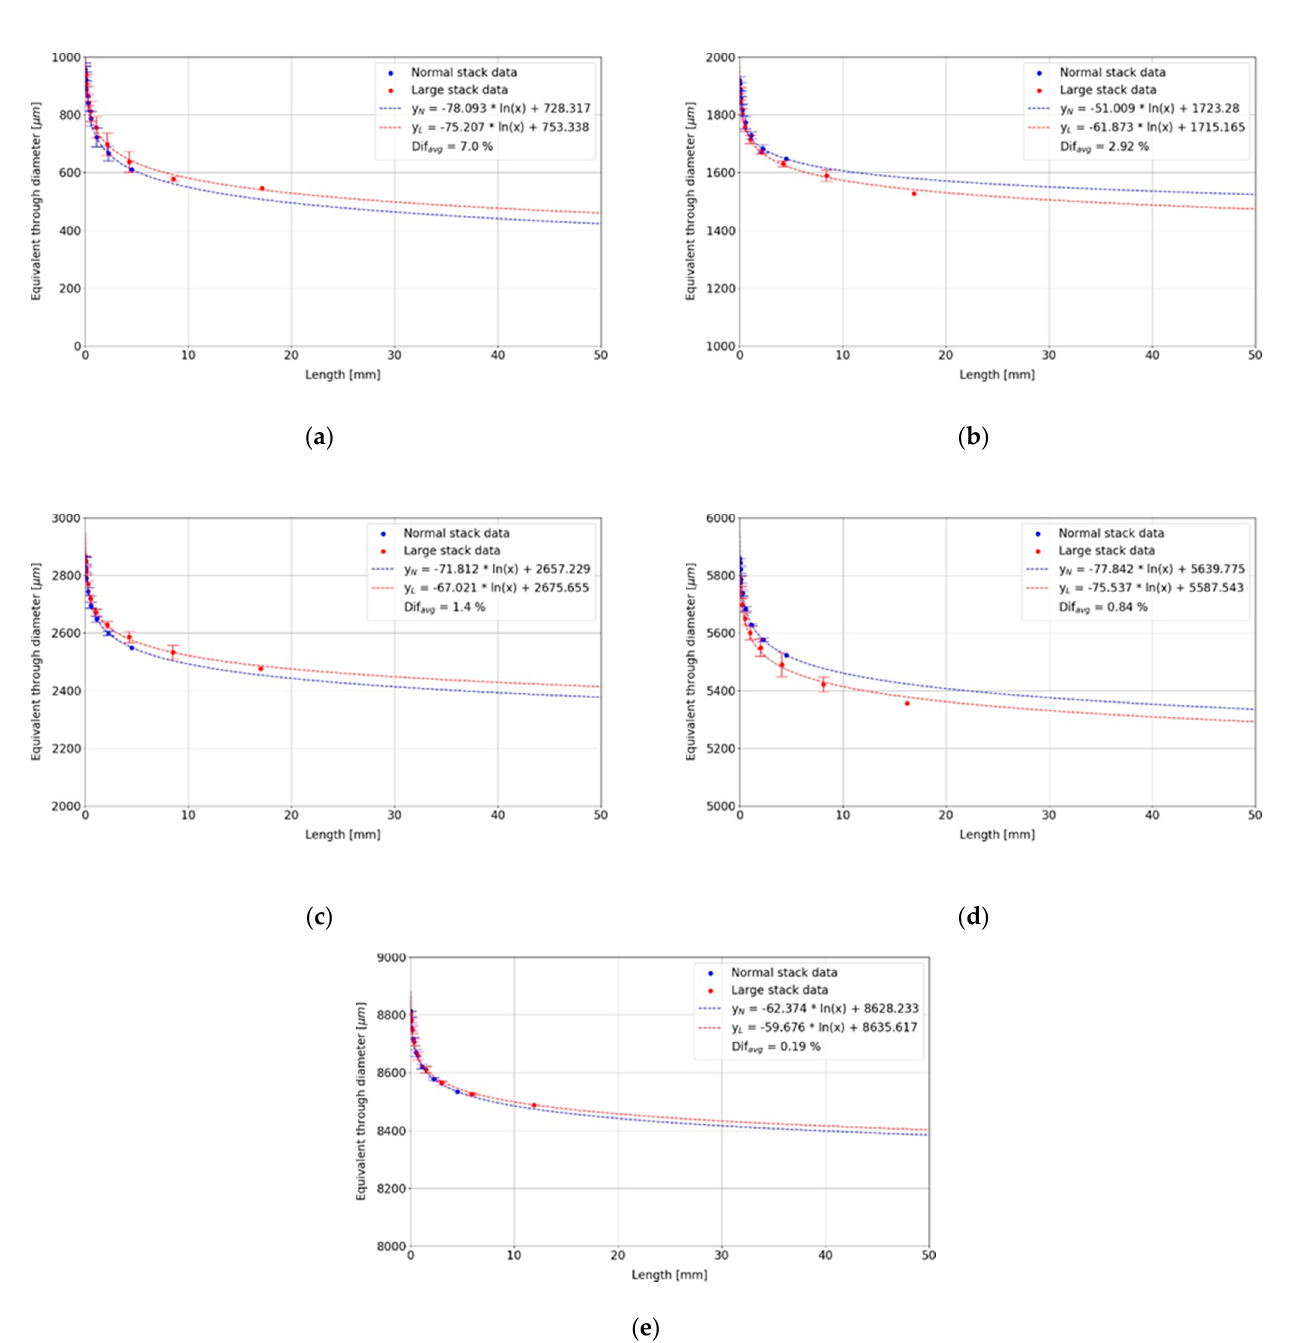
Figure 13. Estimation of the equivalent diameter D eq of the unobstructed area. The length value on the x-axes corresponds to the length of a straight channel segment of which the equivalent diameter may be predicted. ( a ) 1 mm; ( b ) 2 mm; ( c ) 3 mm; ( d ) 6 mm A; ( e ) 9 mm.